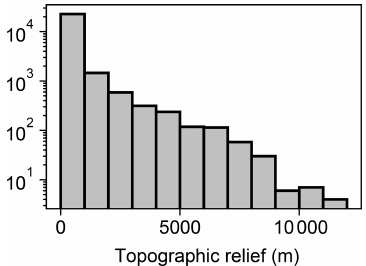
Figure 4. Histogram of topographic relief. The plotted data repre- sent the topographic relief at the trial end of the initial conditions phase of each trial. Note that the y axis is